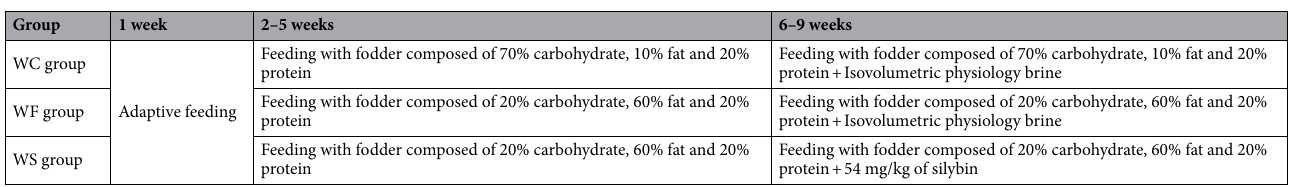
Table 3. Feeding and treatment strategy of the different